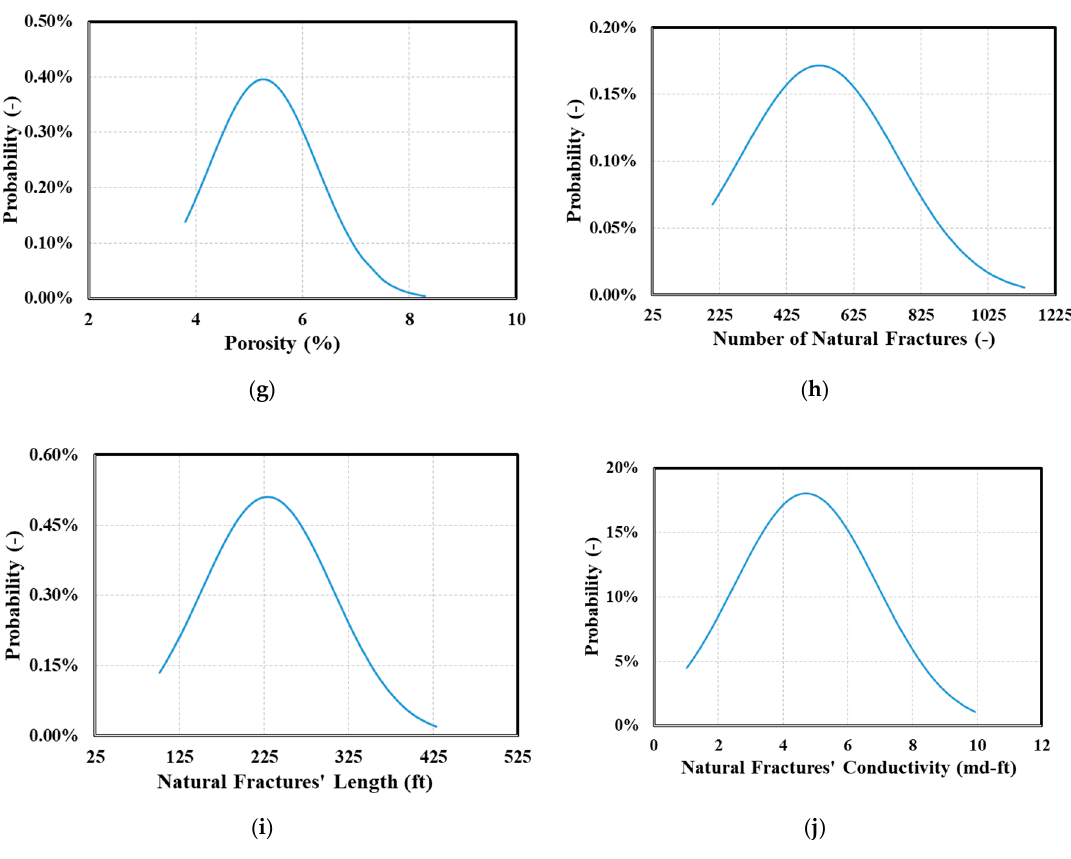
Figure 4. Distributions of the combinations of uncertainty as the inputs of the well spacing optimization workflow, generated from the AHM: ( a ) the matrix permeability distribution; ( b ) the fracture half-length distribution; ( c ) the fracture height distribution; ( d ) the fracture conductivity distribution; ( e ) the fracture water saturation distribution; ( f ) the fracture width distribution; ( g ) the matrix porosity distribution; ( h ) the number of natural fractures’ distribution; ( i ) the natural fractures’ length distribution; and ( j ) the natural fractures’ conductivity distribution.